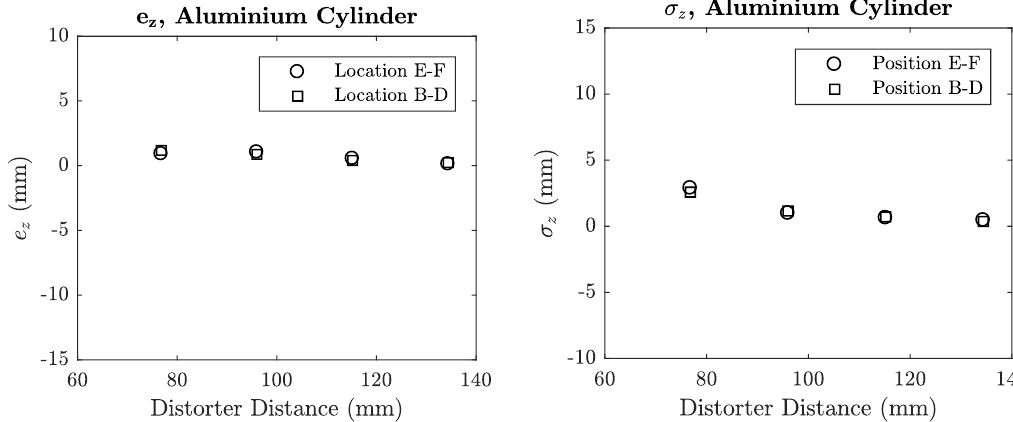
Figure A14. Position error plots for aluminium, cylinder, locations B and D and E to